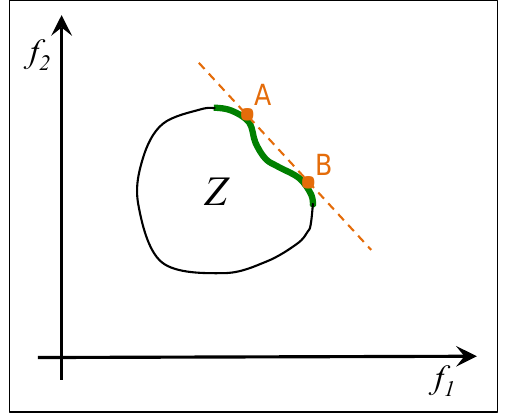
Figure 3. For non-convex Pareto fronts, it is possible that parts of the front can not be obtained by the weighted sum. The region between points A and B is an example of this serious draw back of this aggregation